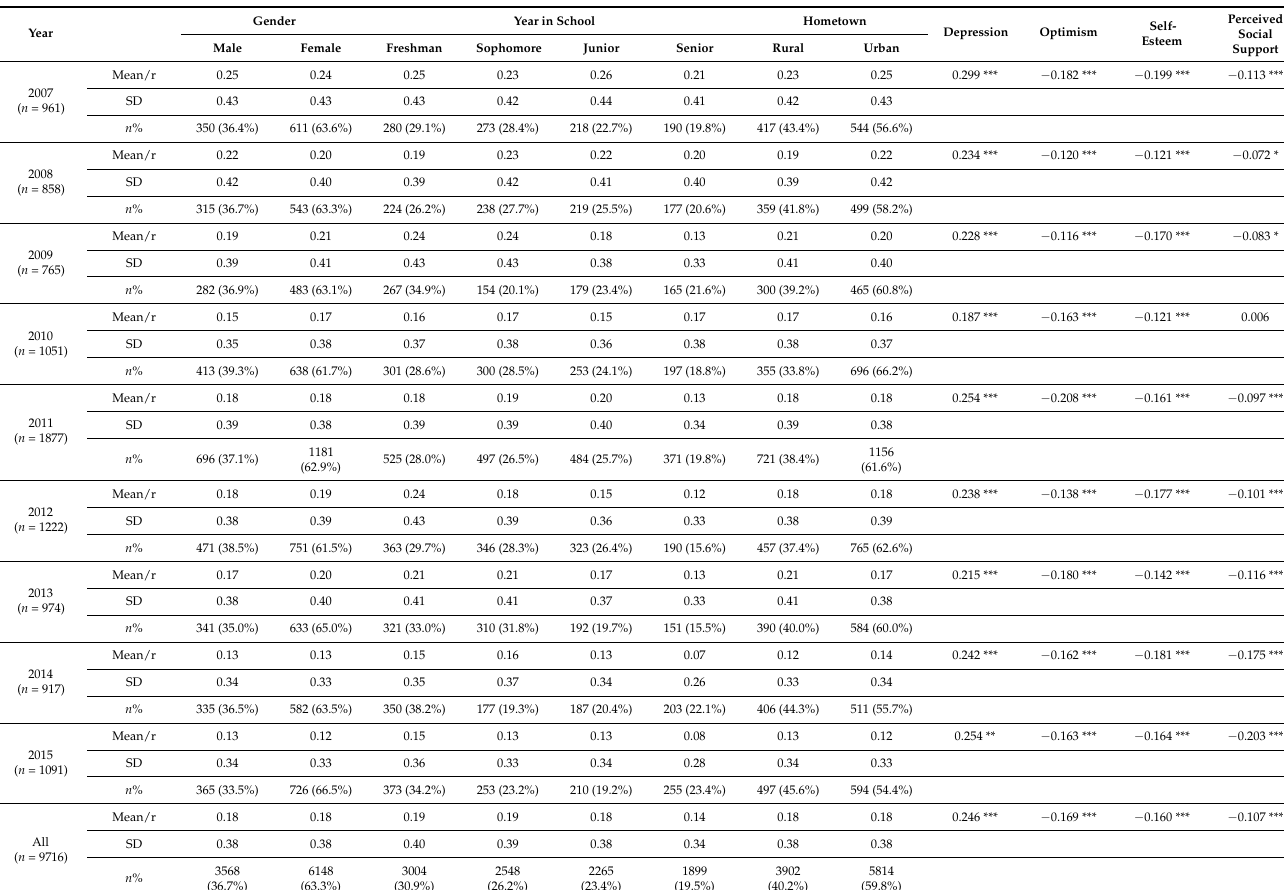
Table 2. Mean rates of suicidal ideation, and correlations between suicidal ideation and optimism, self-esteem, depression, and perceived social